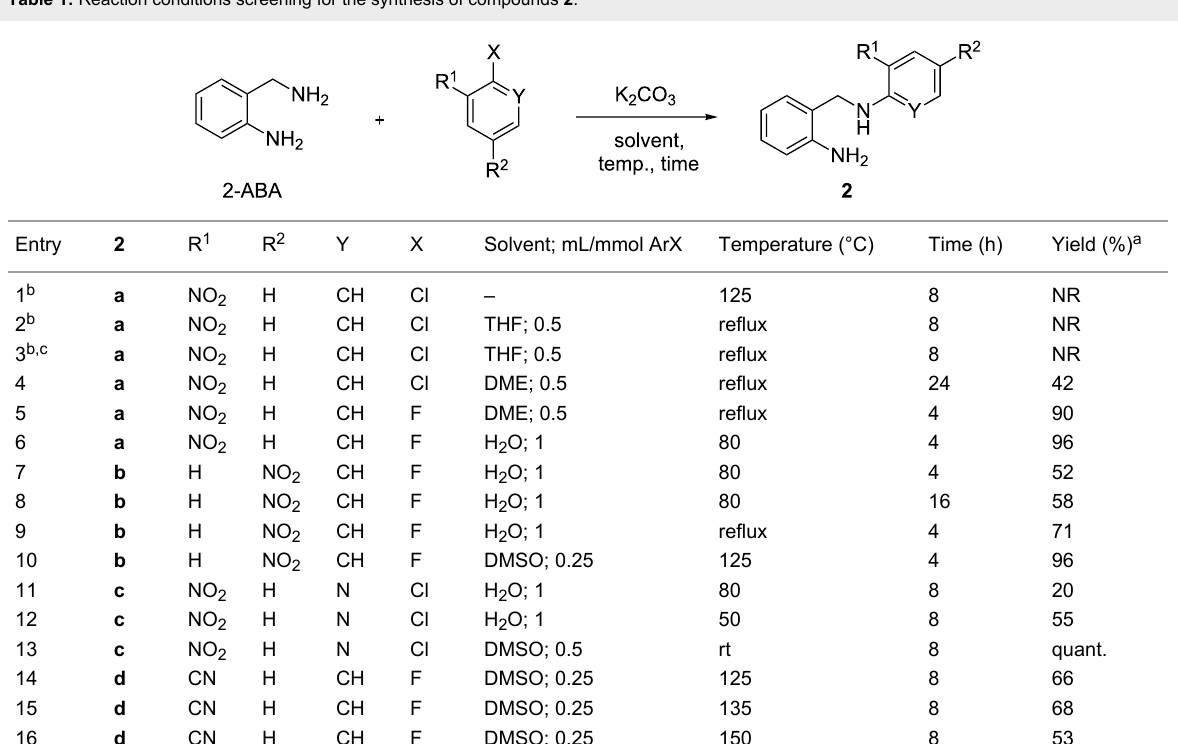
Table 1: Reaction conditions screening for the synthesis of compounds 2 .